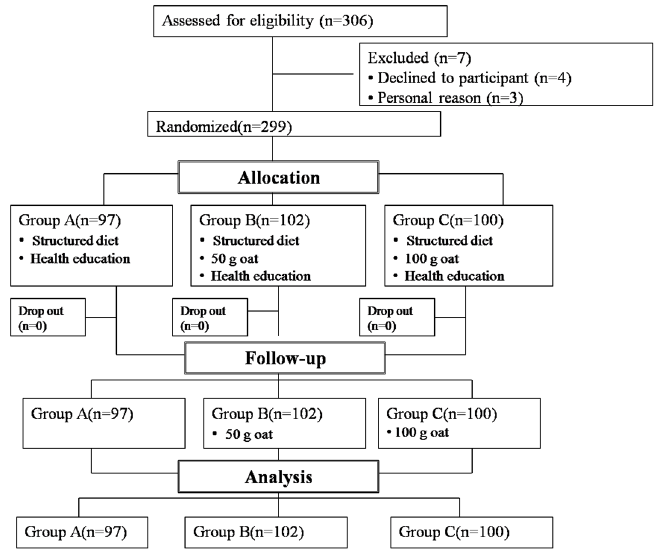
Figure 1. Flow diagram of subjects’ participation in the trial.